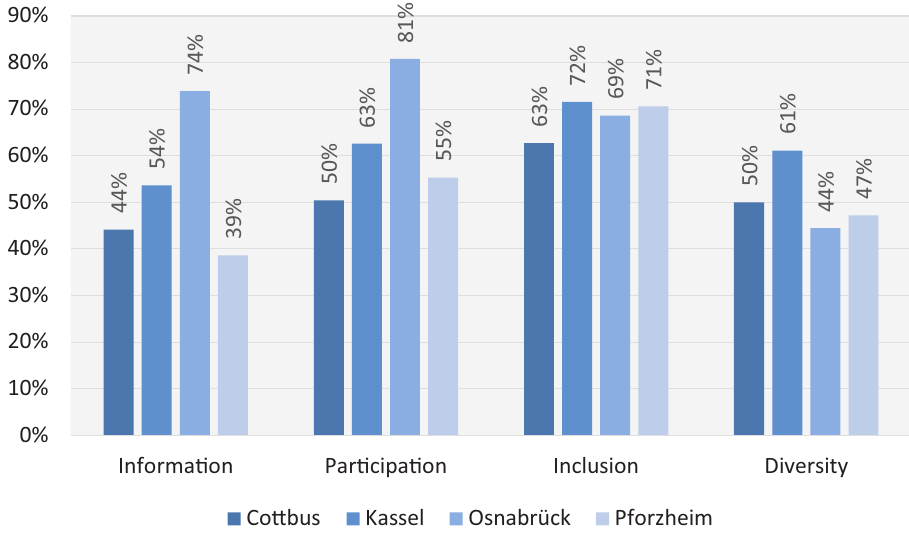
Figure 2. Results in the four dimensions in percentage for each